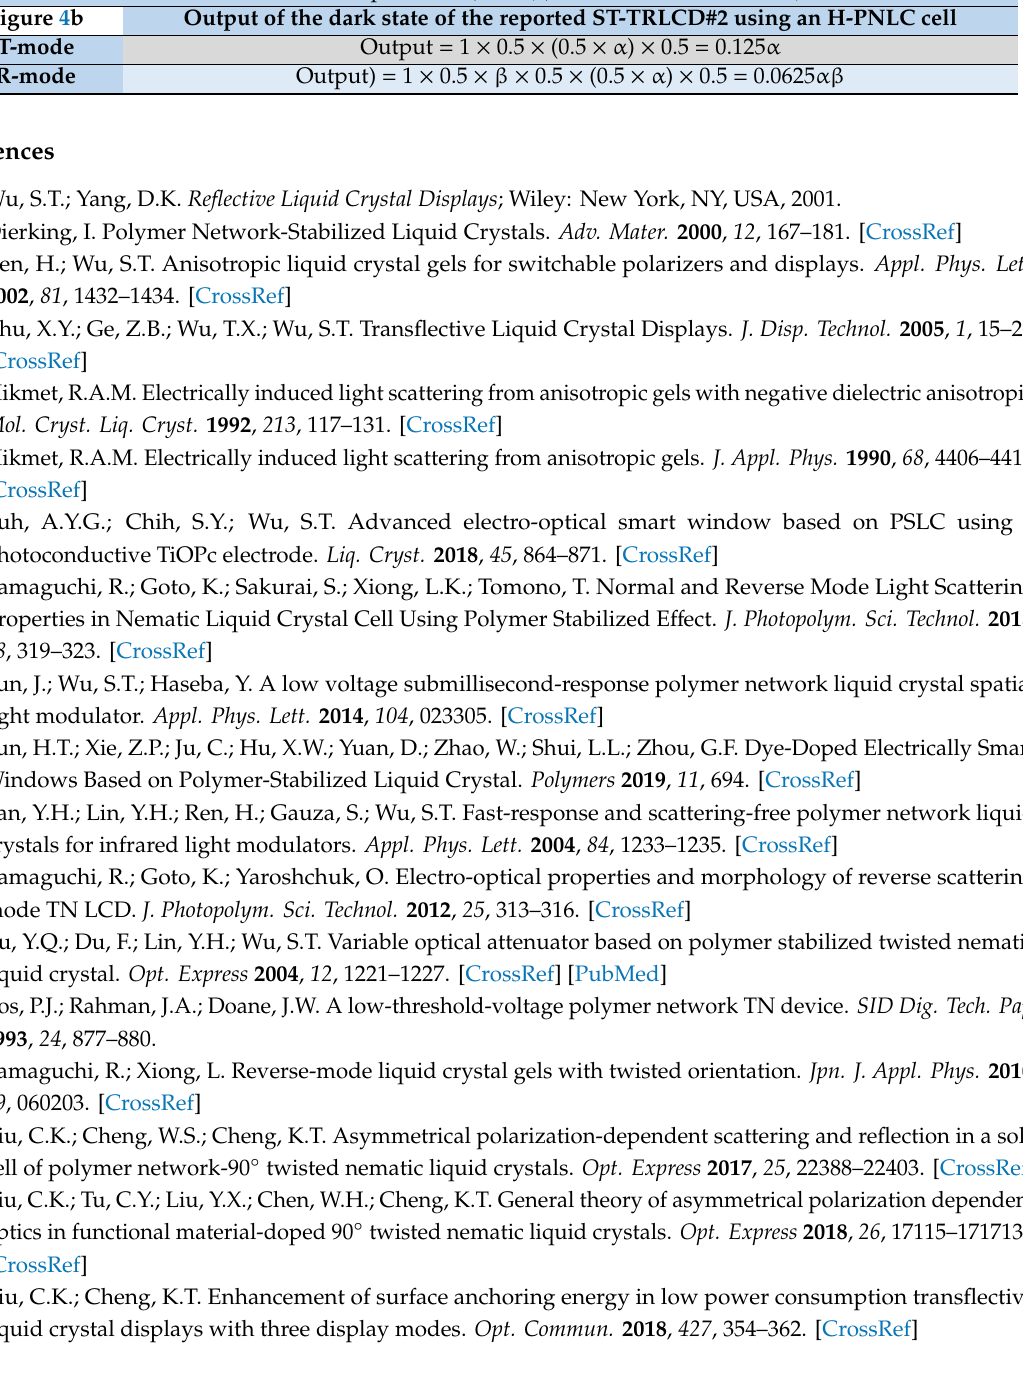
Figure 3b Output of the dark state of the reported ST-TRLCD#1 using an H-PNLC cell T-mode Output = 1 × 0.5 × 0.5 × α = 0.25 α R-mode Output = 1 × (0.5 × β ) × 0.5 × 0.5 × α = 0.125 αβ Figure 4b Output of the dark state of the reported ST-TRLCD#2 using an H-PNLC cell T-mode Output = 1 × 0.5 × (0.5 × α ) × 0.5 = 0.125 α